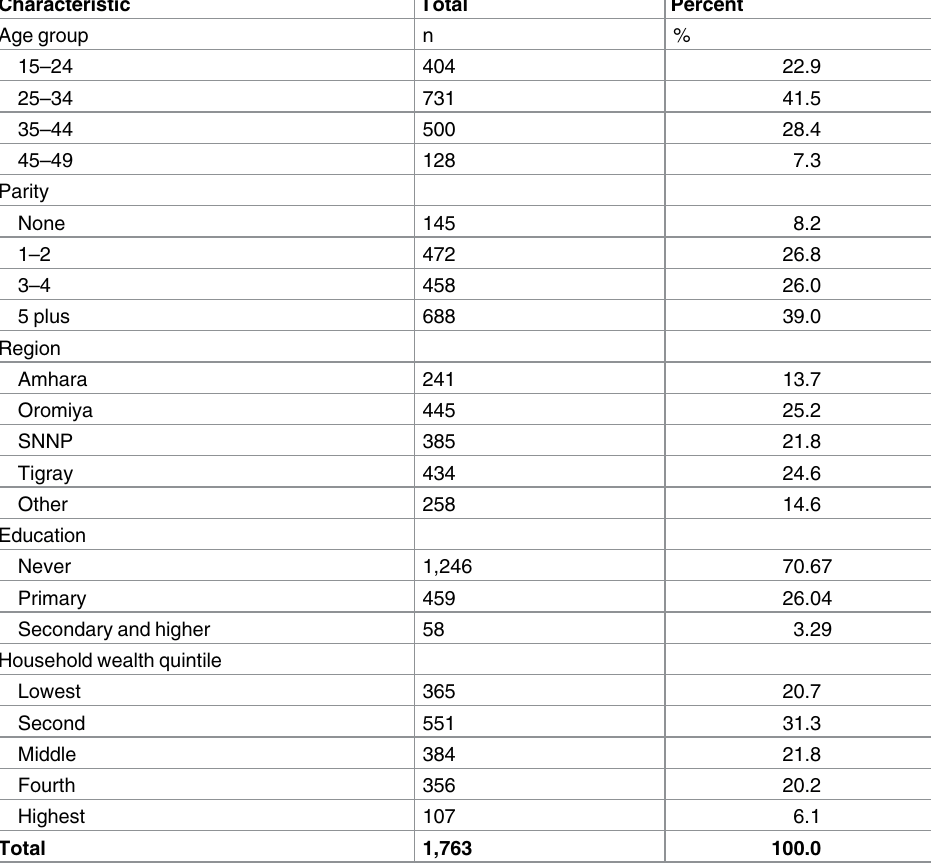
Table 1. Background characteristics for rural married women age 15 to